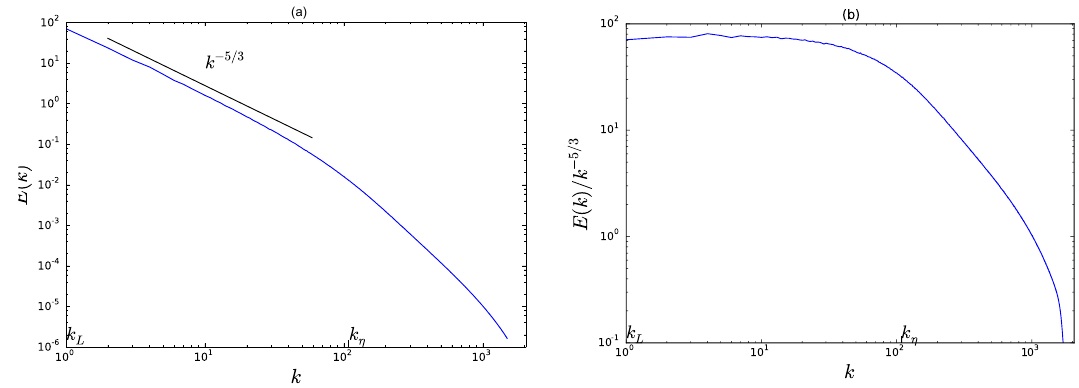
Figure 13. ( a ) energy spectrum E ( k , t ) of the velocity field of DNS of the nonlocal case. The inertial range obeys a Kolmogorov-like behavior ∼ k − 5/3 . ( b ) compensated energy spectrum E ( k ) / k − 5/3 .